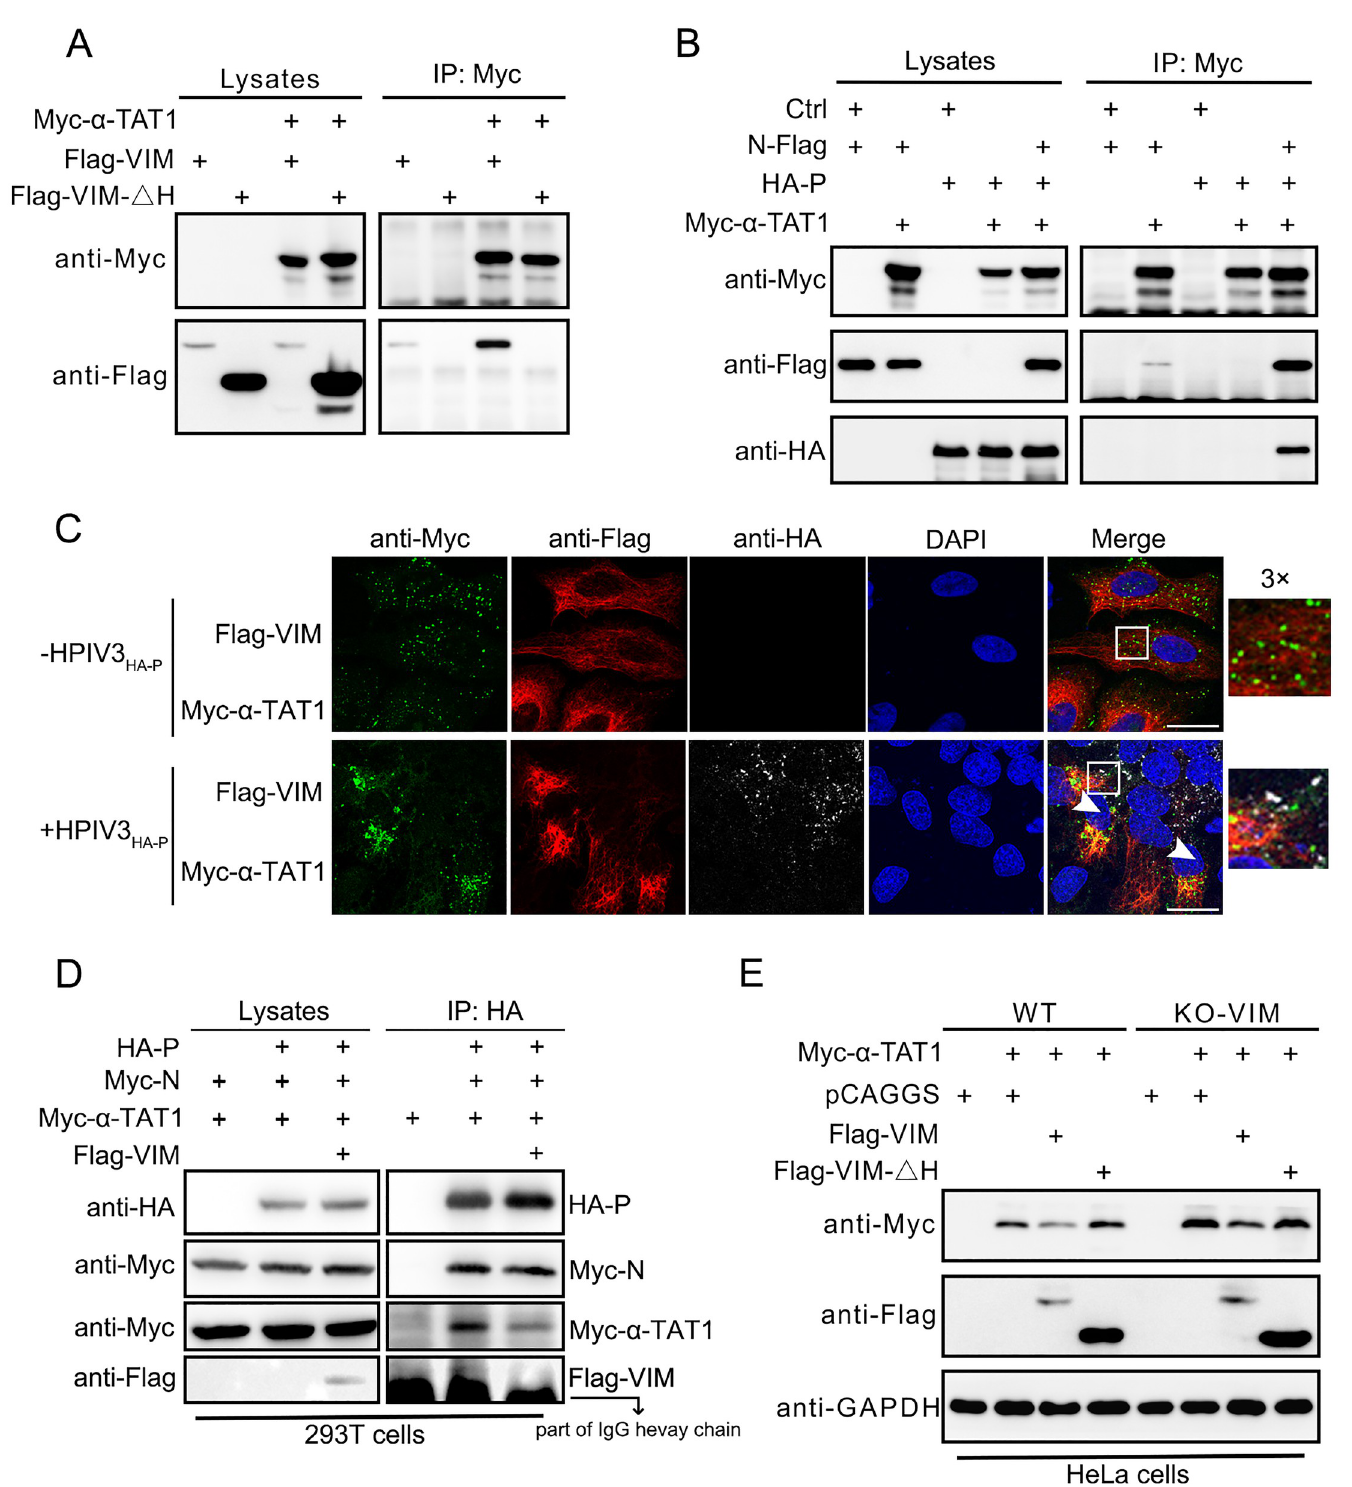
Fig 5. VIM enhances α -TAT1 degradation through its interaction to suppress the formation of HPIV3 IBs. (A) α -TAT1 interacted with VIM but not with VIM Δ H. Myc– α -TAT1 plasmid was co-transfected with Flag–VIM plasmid or Flag–VIM Δ H plasmid in HEK293T cells. Cell lysates were immunoprecipitated using anti-c-Myc tag affinity gel. (B) α -TAT1 interacted with the N–P complex. Myc- α -TAT1, N-Flag, and HA–P plasmid were transfected in HEK293T cells. As IP controls, Myc– α -TAT1 was co-transfected with N-Flag or HA–P. N-Flag or HA–P were individually transfected in groups. Cell lysates were immunoprecipitated using anti-c-Myc tag affinity gel. (C) Localization of VIM, α -TAT1, and HA–P-labeled viral IBs in HeLa cells. HPIV3 HA-P virus was used to show viral IBs. Rat APC-anti-FLAG antibody, mouse anti-c-Myc